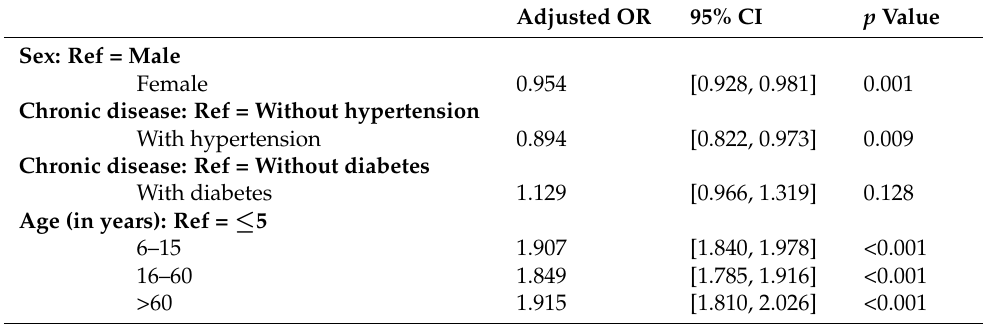
Table 6. Patient-related factors associated with antibiotic prescriptions using binary logistic